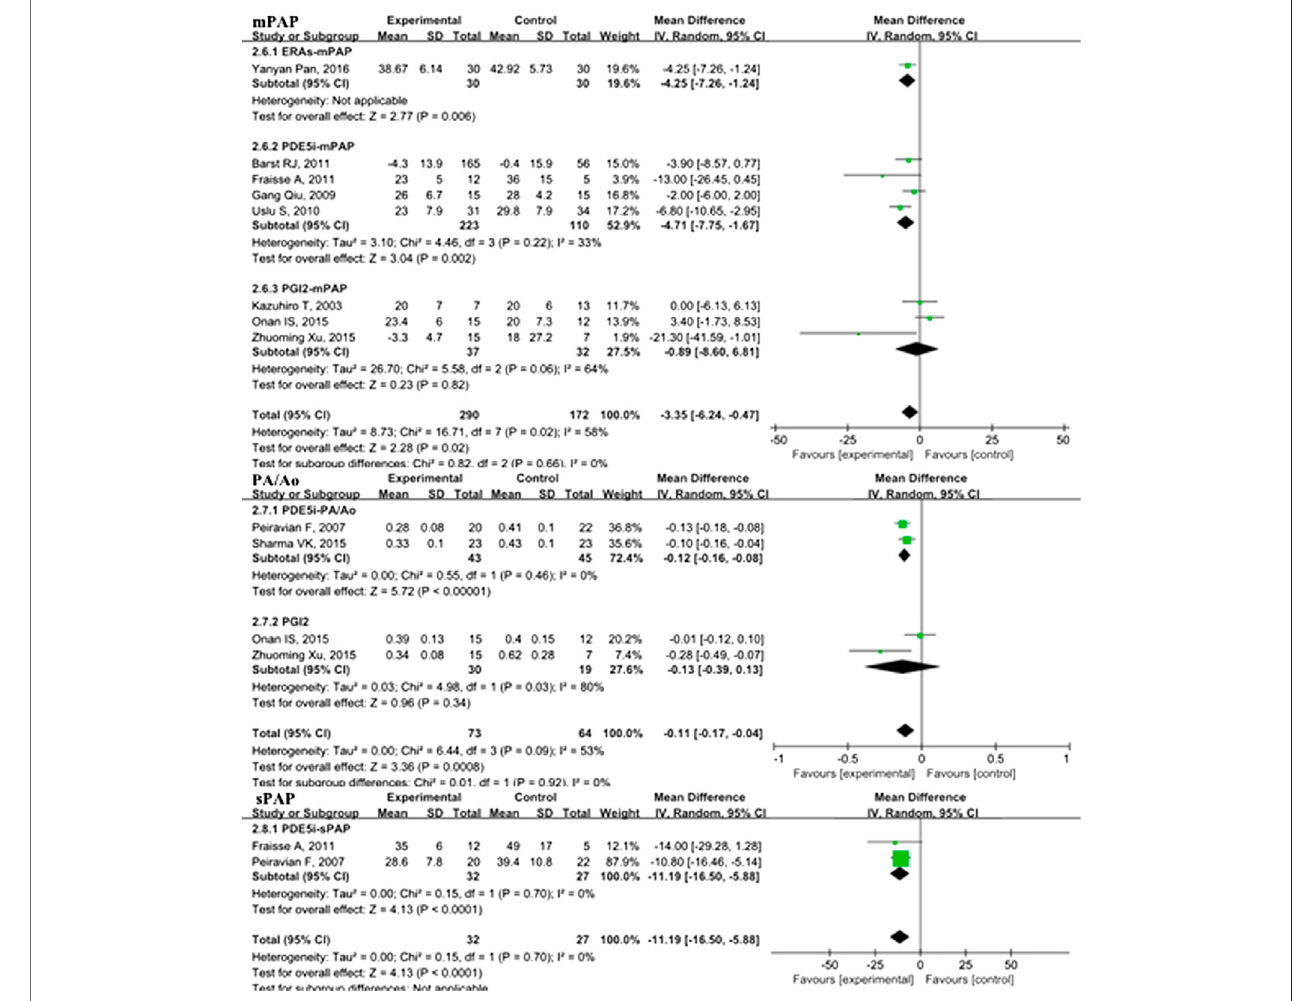
FIGURE 4 | mPAP, PA/Ao, and sPAP in pediatric PH patients treated with pulmonary vasodilators. Abbreviations: mPAP, mean pulmonary artery pressure; PA, pulmonary artery; Ao, aorta; sPAP, systolic pulmonary artery pressure. Other abbreviations are de fi ned in Figure 1 .